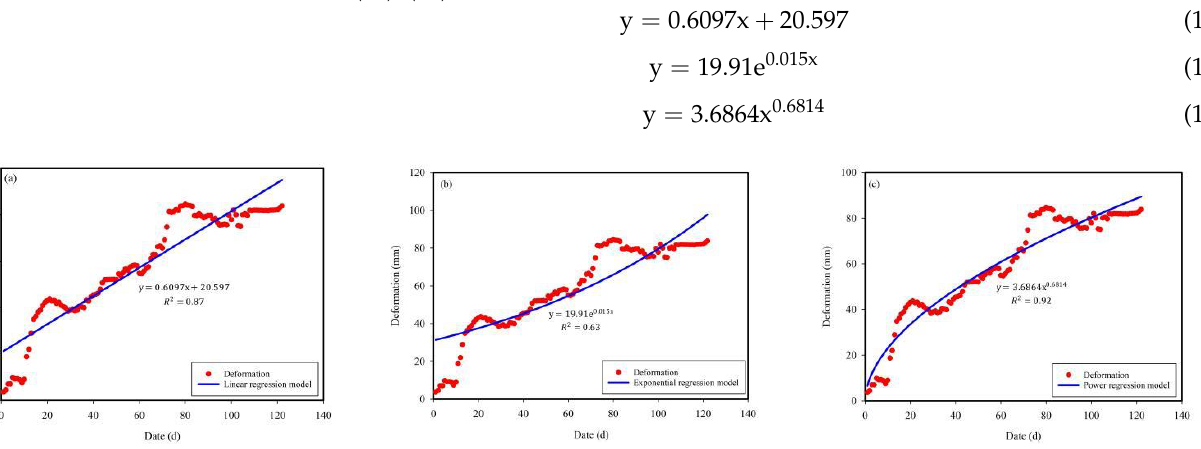
Figure 4. The results of regression analysis in the first threshold interval with different regression models. ( a ) Linear regression model; ( b ) exponential regression model; ( c ) power regression model.